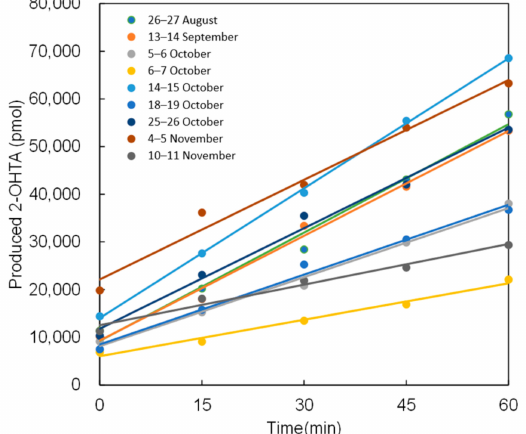
Figure 2. Changes in the amount of produced 2-OHTA with time upon applying the FIA-TPT assay to the PM 2.5 samples collected in Kanagawa, Japan, from August to November 2021 (chart legend: sampling